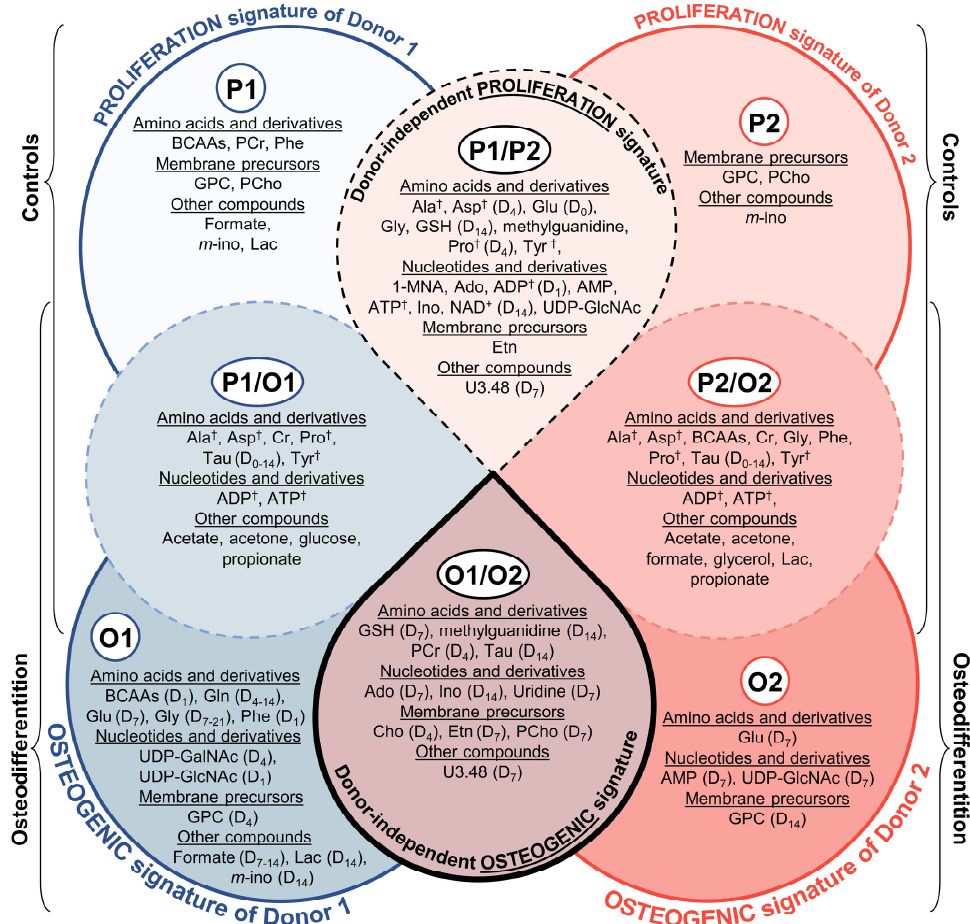
Figure 7. Schematic representation of metabolites proposed to compose donor-dependent and donor- independent signatures of MSCs proliferation and osteodifferentiation. Donor 1 (blue) and donor 2 (red) individual metabolic signatures, exclusive of proliferation and osteodifferentiation are shown in sections Pi and Oi (where i is the donor number), respectively. Metabolites changing in common to proliferation and osteodifferentiation are situated in overlapped sections Pi/Oi (i: donor number). Proliferation-specific and osteodifferentiation-specific metabolic signatures (mutually exclusive) shared by both donors are listed in the overlapped sections P1/P2 and O1/O2, respectively. Each of the overlapped sections P1/P2, P1/O1 and P2/O2 include metabolites that (i) vary similarly throughout the 21 days (metabolites without any time specification), (ii) converge between days i and j (D i–j ) or (iii) converge after day i (D i ). Furthermore, metabolites in sections O1, O2 and O1/O2 are followed by the indication of the day (D i ) or time period (D i–j ) after/during which the metabolites are considered osteospecific. Importantly, metabolites highlighted with † appear in more than one section but follow similar time course trajectories, whereas repeated metabolites without the † indication vary differently in each section. Compound abbreviations as defined in the caption of Figure